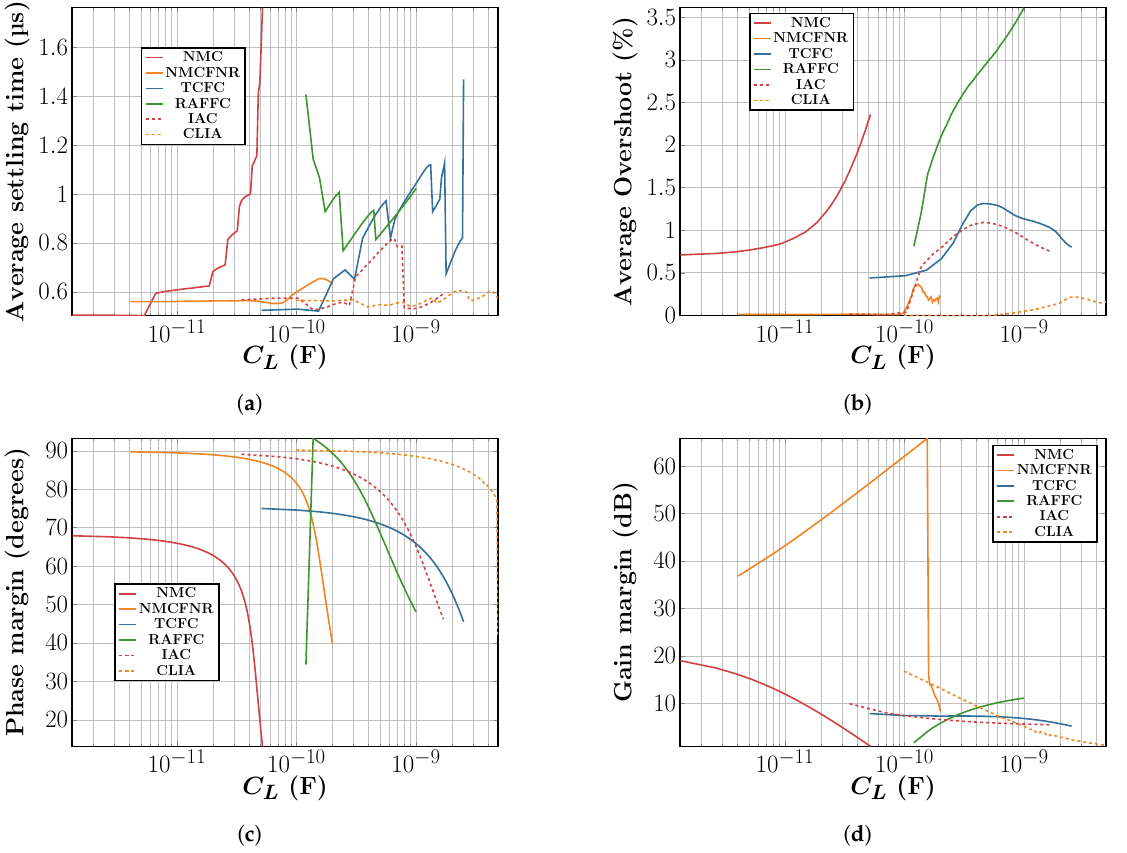
Figure 14. Simulation results for the chosen OTA architectures showing: ( a ) settling time; ( b ) overshoot; ( c ) phase margin; and ( d ) gain margin as functions of the load capacitance.